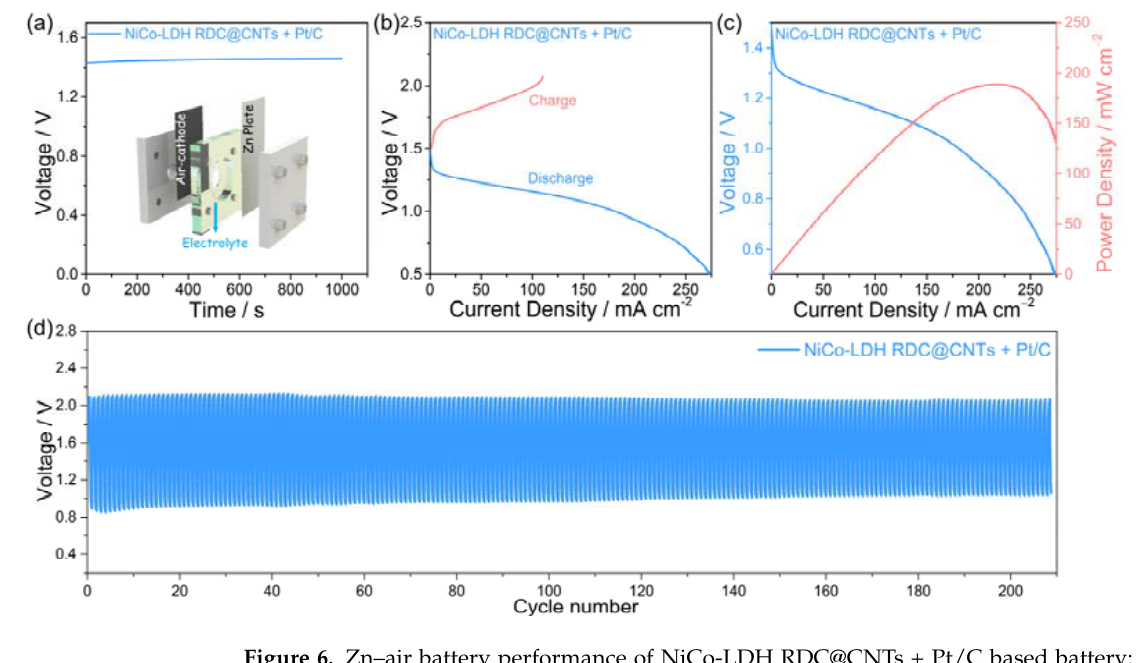
Figure 6. Zn–air battery performance of NiCo-LDH RDC@CNTs + Pt/C based battery: ( a ) OCV plots, and the inset shows the schematic illustration of Zn–air battery configuration. ( b ) The charge–discharge polarization curves; ( c ) discharge polarization curve and corresponding power density profile. ( d ) The galvanostatic charge-discharge curves of the Zn–air battery.